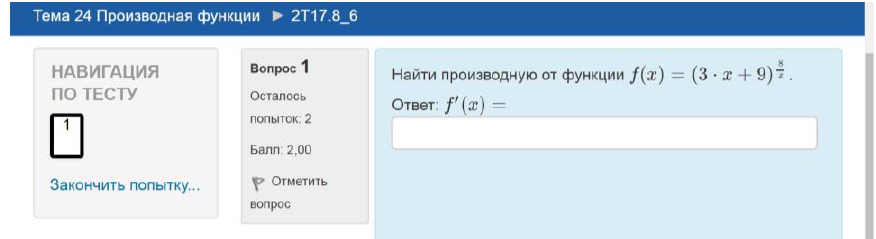
Fig. 3. STACK question on finding a derivative (TUSUR) / Theme 24. Derivative function / test navigation, finish attempt / question, attempts left, score, mark the question / find a derivative of the function. Answer.